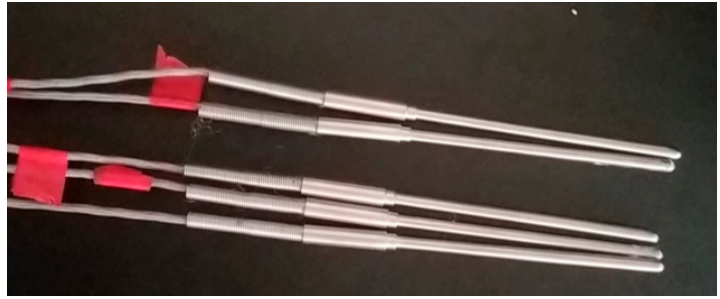
Figure 3. The three-wire PT100A platinum resistor.